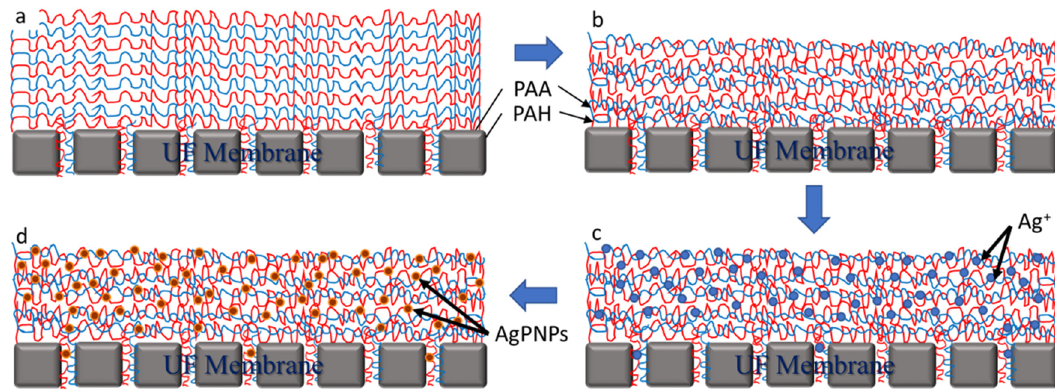
Figure 1. Schematic of the ultrafiltration (UF) membrane functionalization process sequence: ( a ) bilayer coating of virgin UF membrane with polyallylamine hydrochloride (PAH) and polyacrylic acid (PAA); ( b ) crosslinking of bilayers using 0.5% 1-ethyl-3-(3-dimethylamionopropyl) carbodiimide (EDAC); ( c ) Ag + loading within the bilayers by soaking in 5 mM AgC 2 H 3 O 2 solution; ( d ) formation of stable silver phosphate nanoparticle (AgPNPs) by soaking in 0.2 M Na 2 HPO 4 solution. Table 1. UF membranes tested and functionalized for different experiments in this study. No. of PAH/PAA Membrane Membrane Description Bilayers (BL) Tested/Functionalized Deposited Commercial unmodified UF